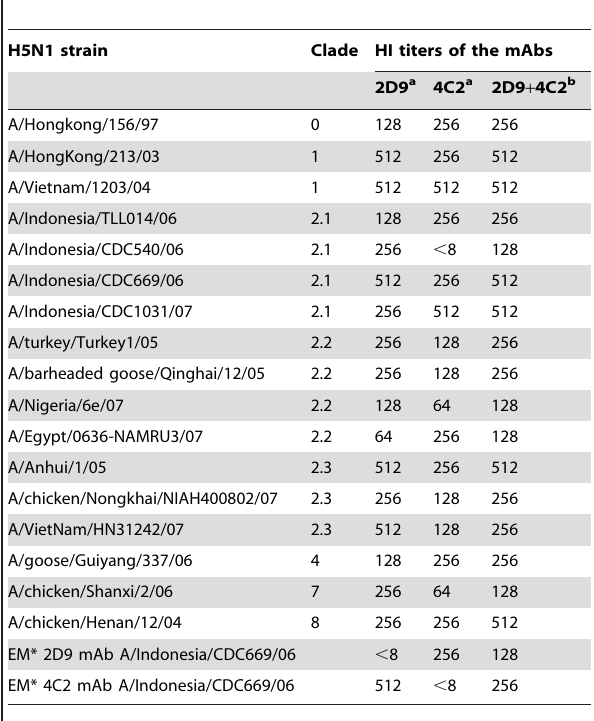
Table 2. Hemagglutination Inhibition (HI) titers of the mAbs against H5N1 influenza viruses.